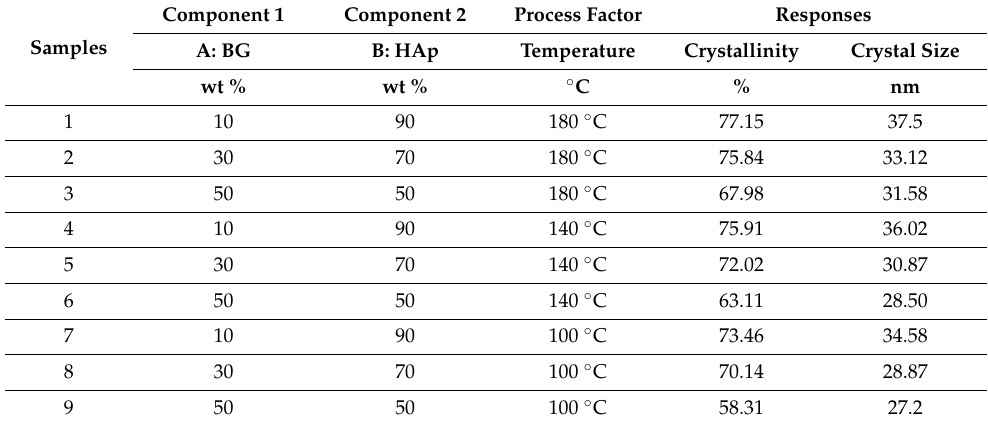
Table 4 . Crystallinity and crystal size of HAp/BG composites at hydrothermal process temperature 100 °C .